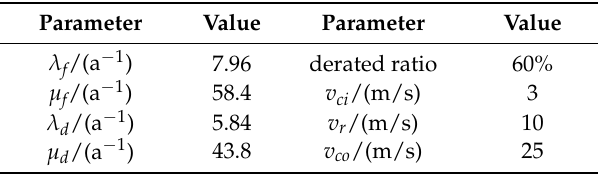
Table 1. Reliability parameters of the 3MW-WTGs.